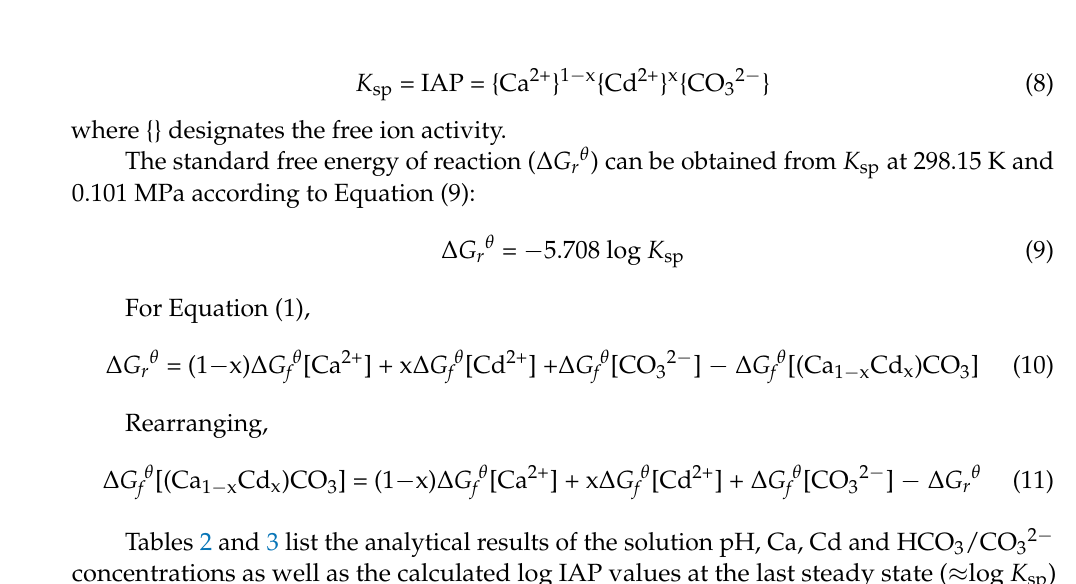
Tables 2 and 3 list the analytical results of the solution pH, Ca, Cd and HCO 3 /CO 32 −